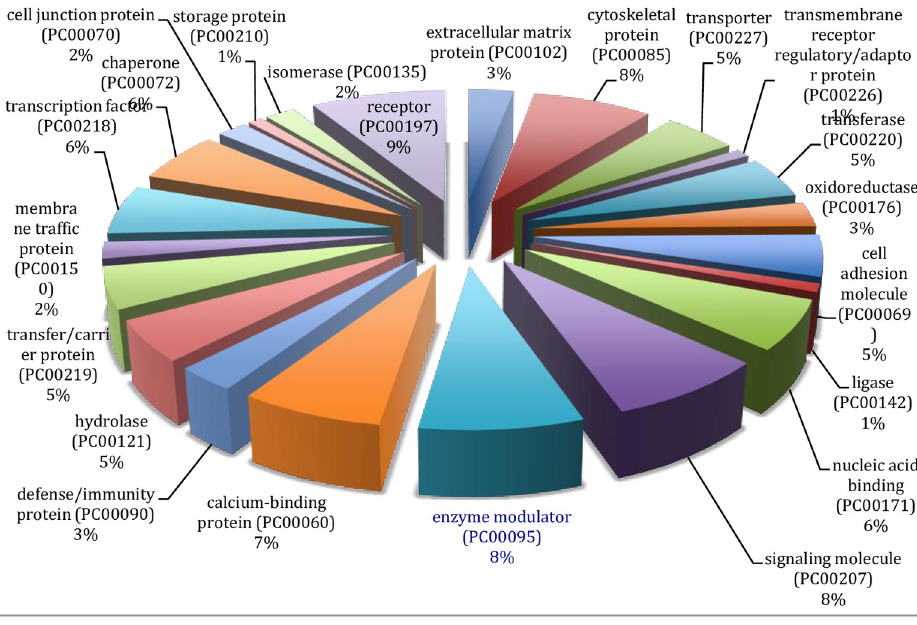
Fig 6. Gene ontology classification of upregulated differentially expressed genes in pansteatitis according to the protein types.